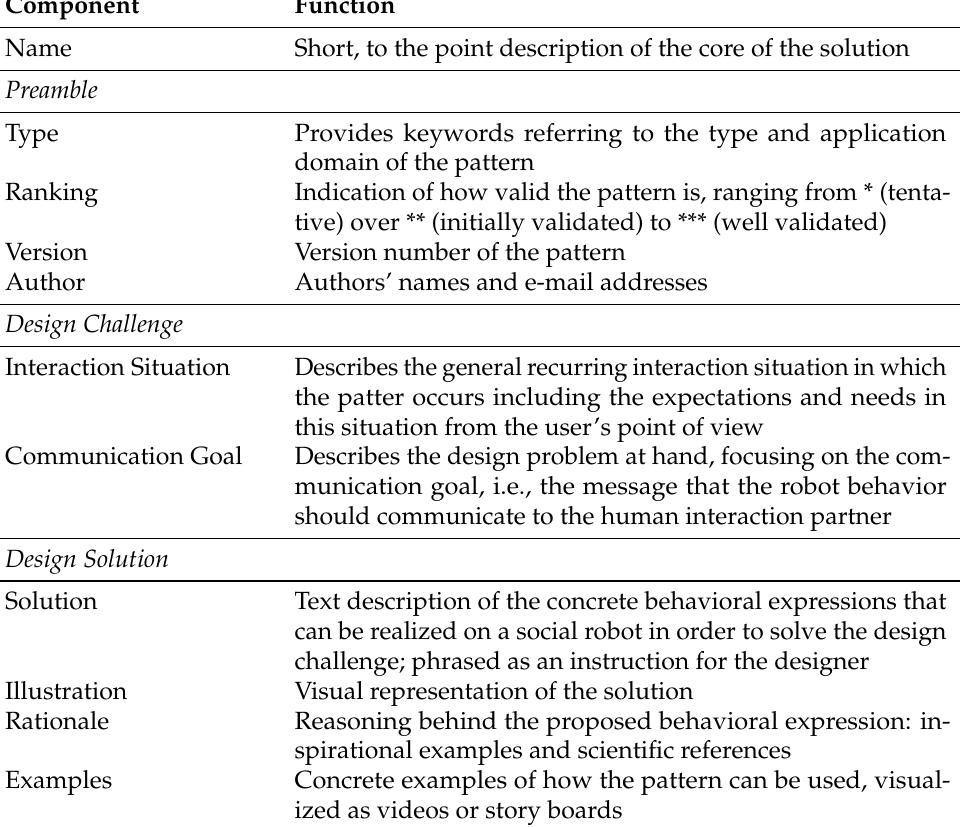
Table 3. Overview of the pattern components and their contents (based on